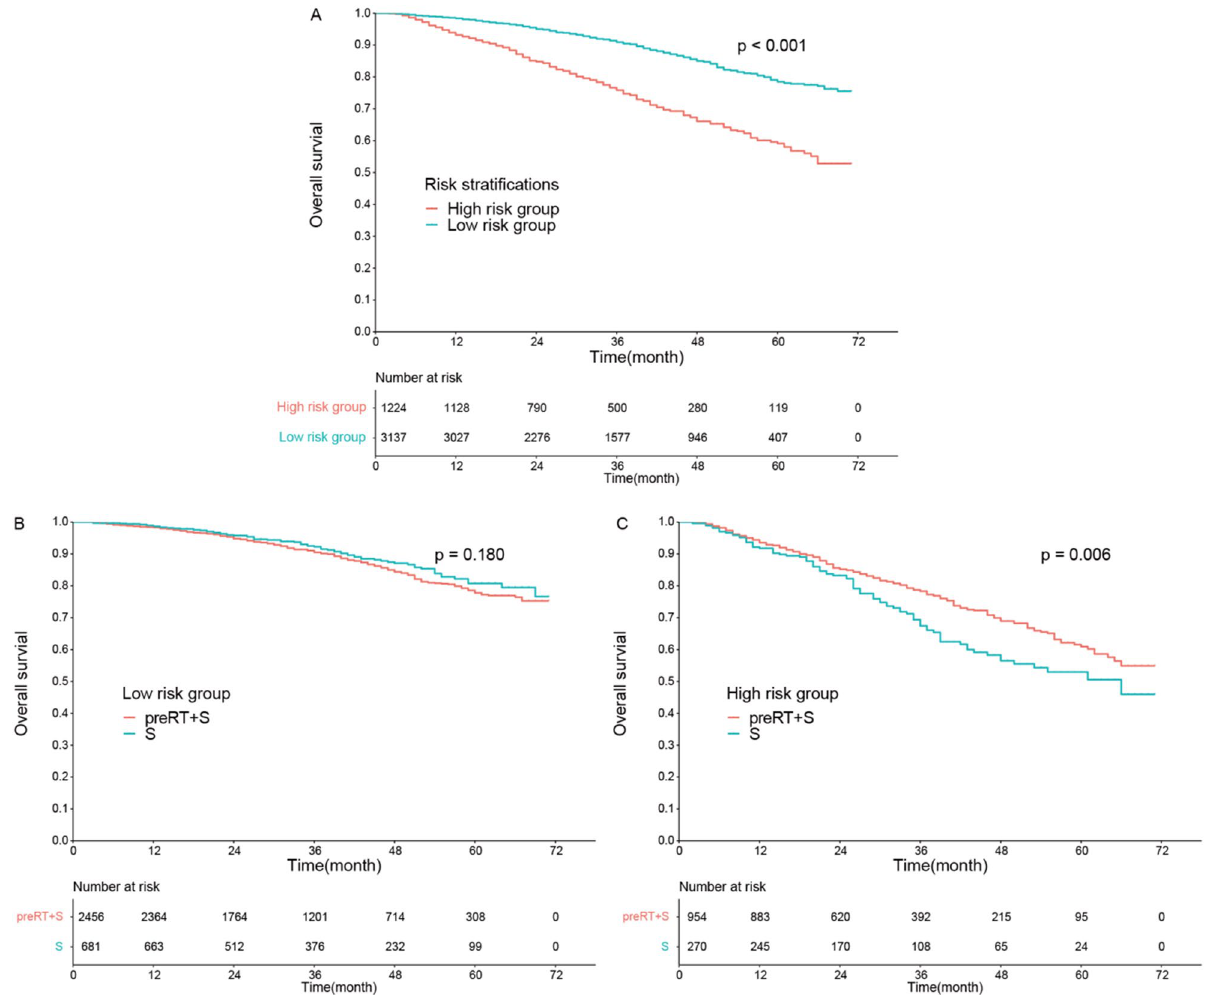
Figure 4. Kaplan–Meier analysis of overall survival according to ( A ) risk stratification; ( B ) preoperative radiotherapy (preRT) for low ‐ risk patients and ( C ) preoperative radiotherapy for high ‐ risk patients. S